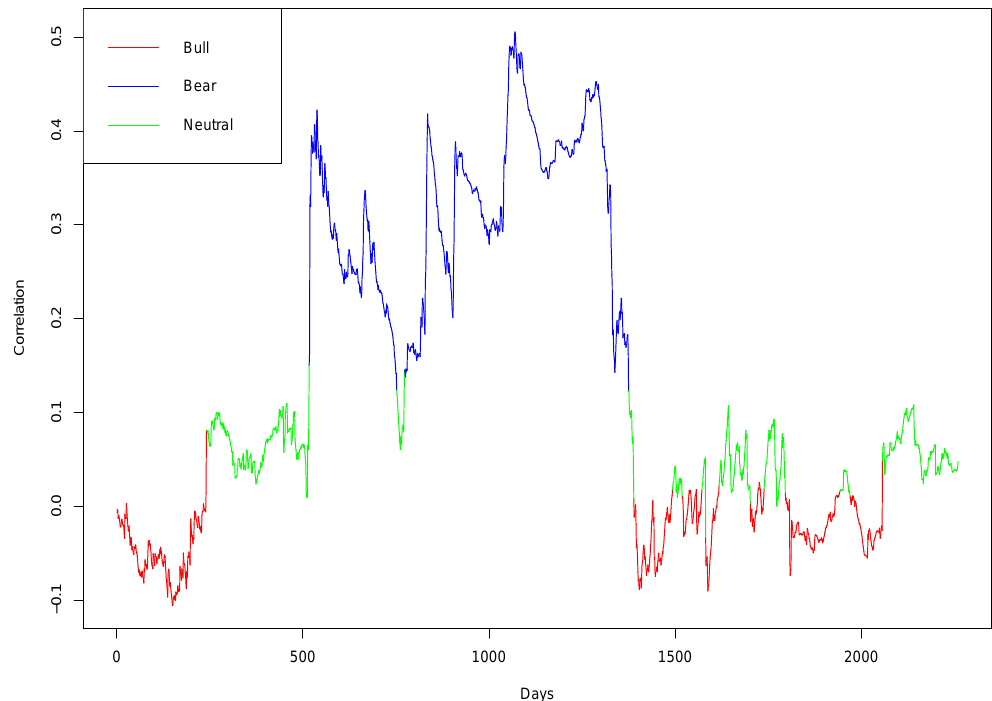
Figure 4. Estimation of market states through changing correlations between volume of news and mean long-term bond spread in